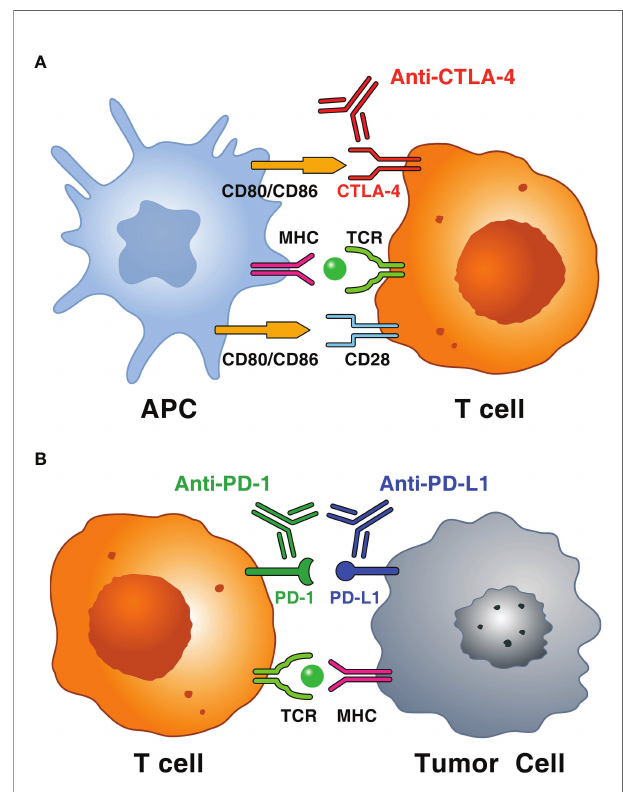
FIGURE 1 | Schematic representation of immune mechanisms of immune checkpoints and immune checkpoint inhibitors (ICIs). (A) T cells, particularly CD4 + T cells in the lymph node, recognize tumor antigens in the context of MHC molecules or antigen-presenting cell (APC) and T cell receptor (TCR) on T cells. The interaction between CD80 (also known as B7-1) or CD86 (also known as B7-2) on APC and CD28 mediates T cell co-stimulation in conjunction with TCR signals. CTLA-4 on activated T cell interacts with both ligands (i.e., CD80 or CD86) with higher af fi nity and avidity than CD28 and, unlike CD28, sends an inhibitory signal to T cell. Monoclonal antibodies anti- CTLA-4 (i.e., ipilimumab) block this inhibitory pathway restoring T cell activity. (B) T cells, particularly cytotoxic CD8 + T cells, which recognize tumor antigens in the context of MHC class, result in the adaptive expression of PD- L1 on the surface of tumor cells. The interaction between PD-1 and PD-L1 negatively regulates the anti-tumor T cell response. This interaction is useful in preventing autoimmunity in physiological conditions, whereas cancer cells exploit this mechanism to escape from immune system upregulating PD-L1 expression. Anti-PD-1 (i.e., pembrolizumab, nivolumab and cemiplimab) and anti-PD-L1 mAbs (i.e., atezolizumab, avelumab and durvalumab) block this inhibitory pathway restoring T cell